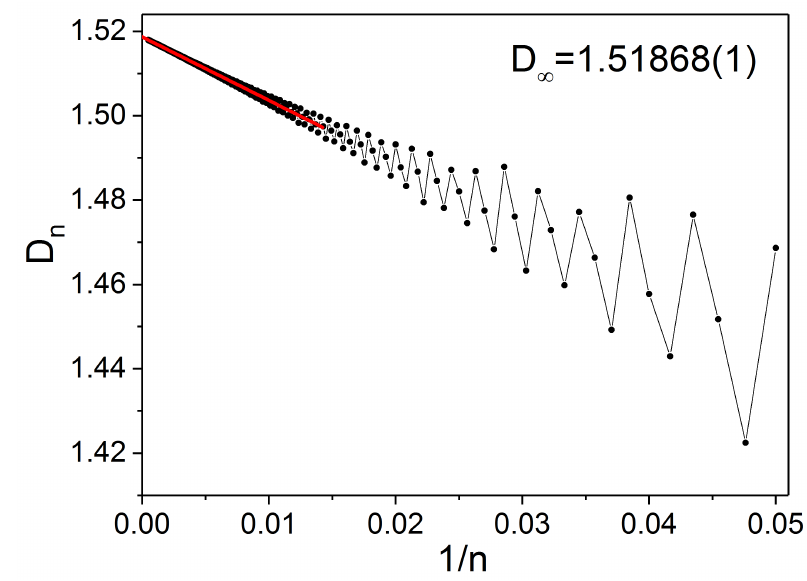
Figure 1. D n as a function of 1/ n , and linear extrapolation (red